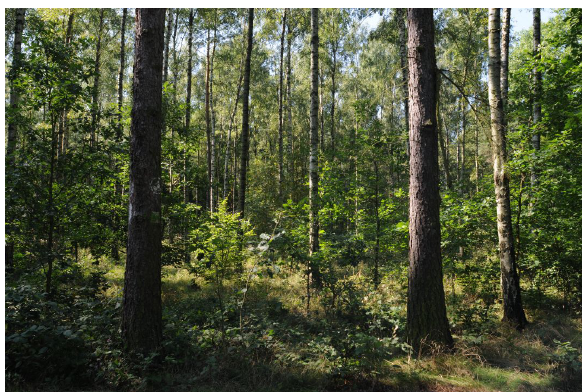
Figure 2: Example image of captured stack with 36 frames over-